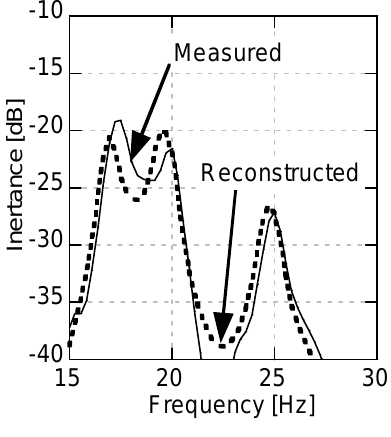
Fig. 16. Vehicle B, RE-FF, FRF of point